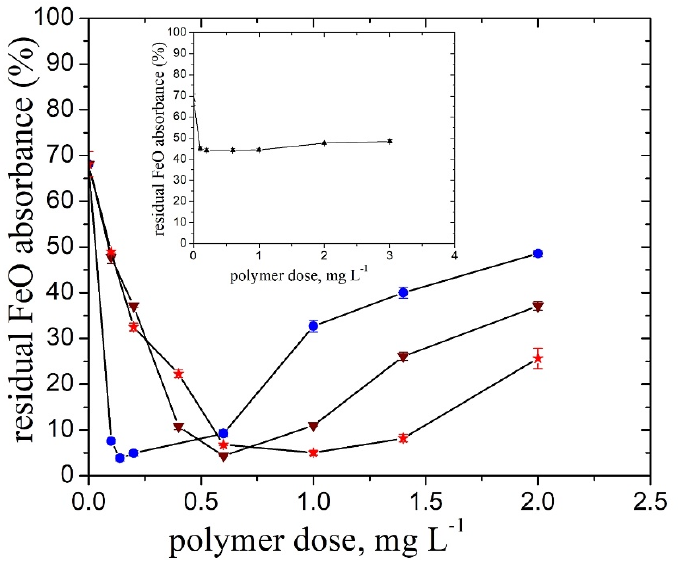
Figure 1. The residual FeO absorbance (%) dependence on the polymer dose for: TMAP 0.7 –P (circle); TMAP 0.4 –P (inverted triangle); TMAP 0.2 –P ; (star); the inset: P (triangle); c ip = 1 g L − 1 , c FeO = 0.4 g L − 1 , pH = 8.34, settling time 120 min.